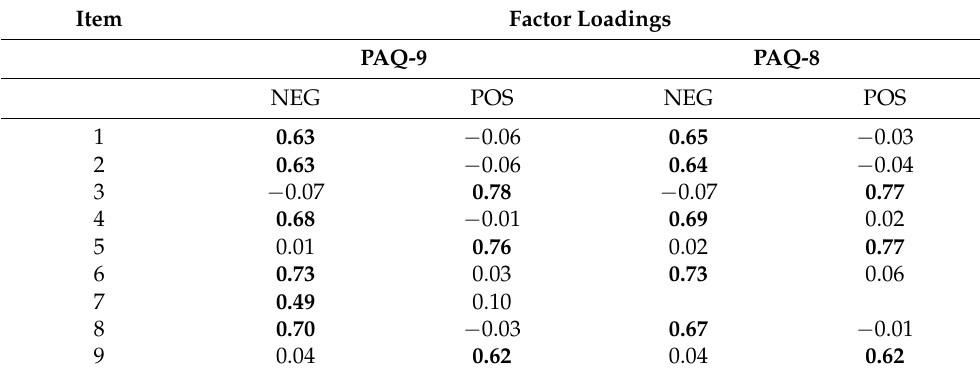
Table 3. PAQ item factors loadings based on Exploratory Factor Analysis (Analysis